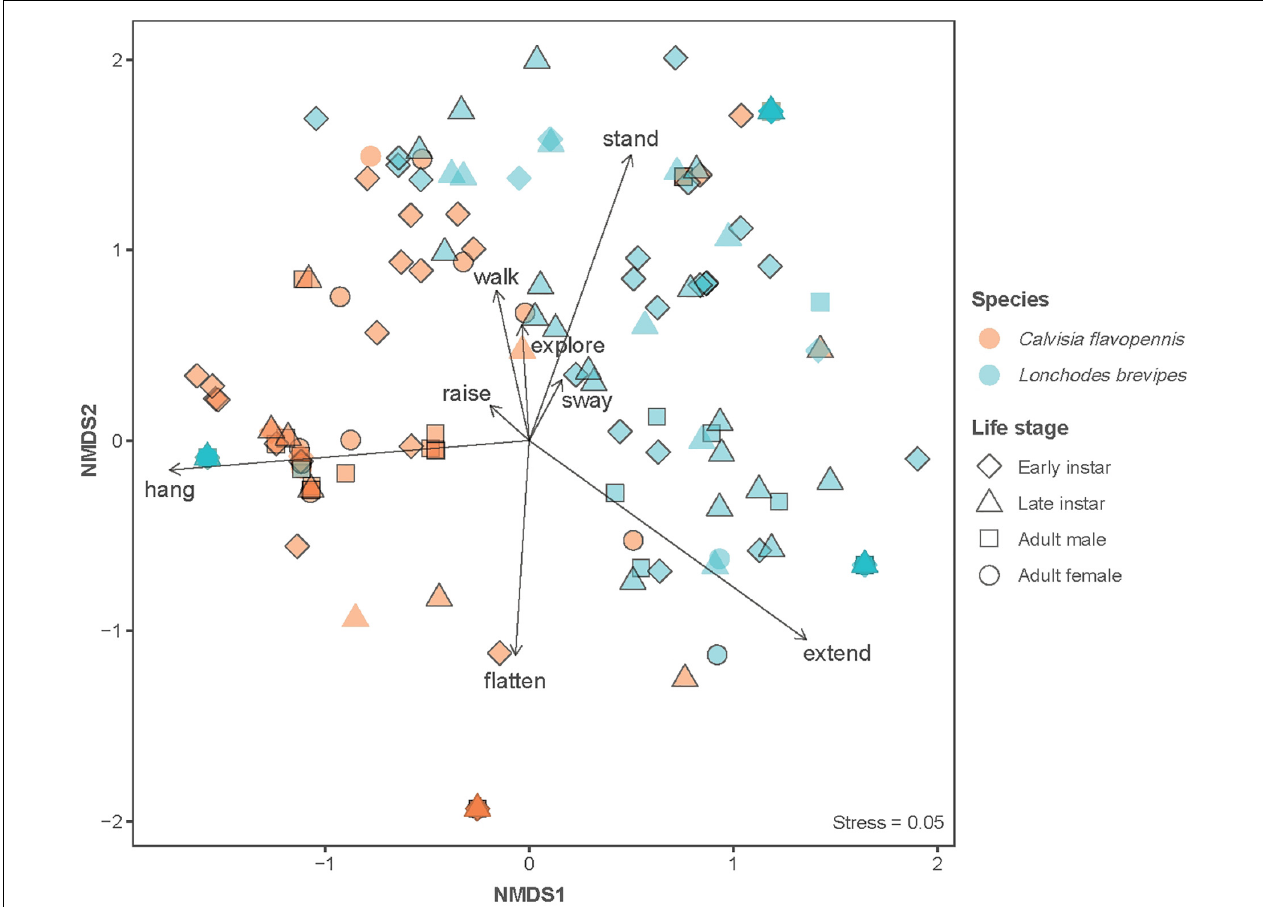
FIGURE 2 | Non-metric multidimensional scaling (NMDS) plot to visualize the differences in behavioral responses. Symbol shape indicates life stage, while symbol color indicates species. Symbols without black outline indicate control observations, while symbols with black outline indicate observations with wind stimulus. Arrows indicate behaviors that significantly contributed to data separation, with arrow length indicating relative contribution. The stress value is reported as an indicator of disagreement in the reduced dimensions.